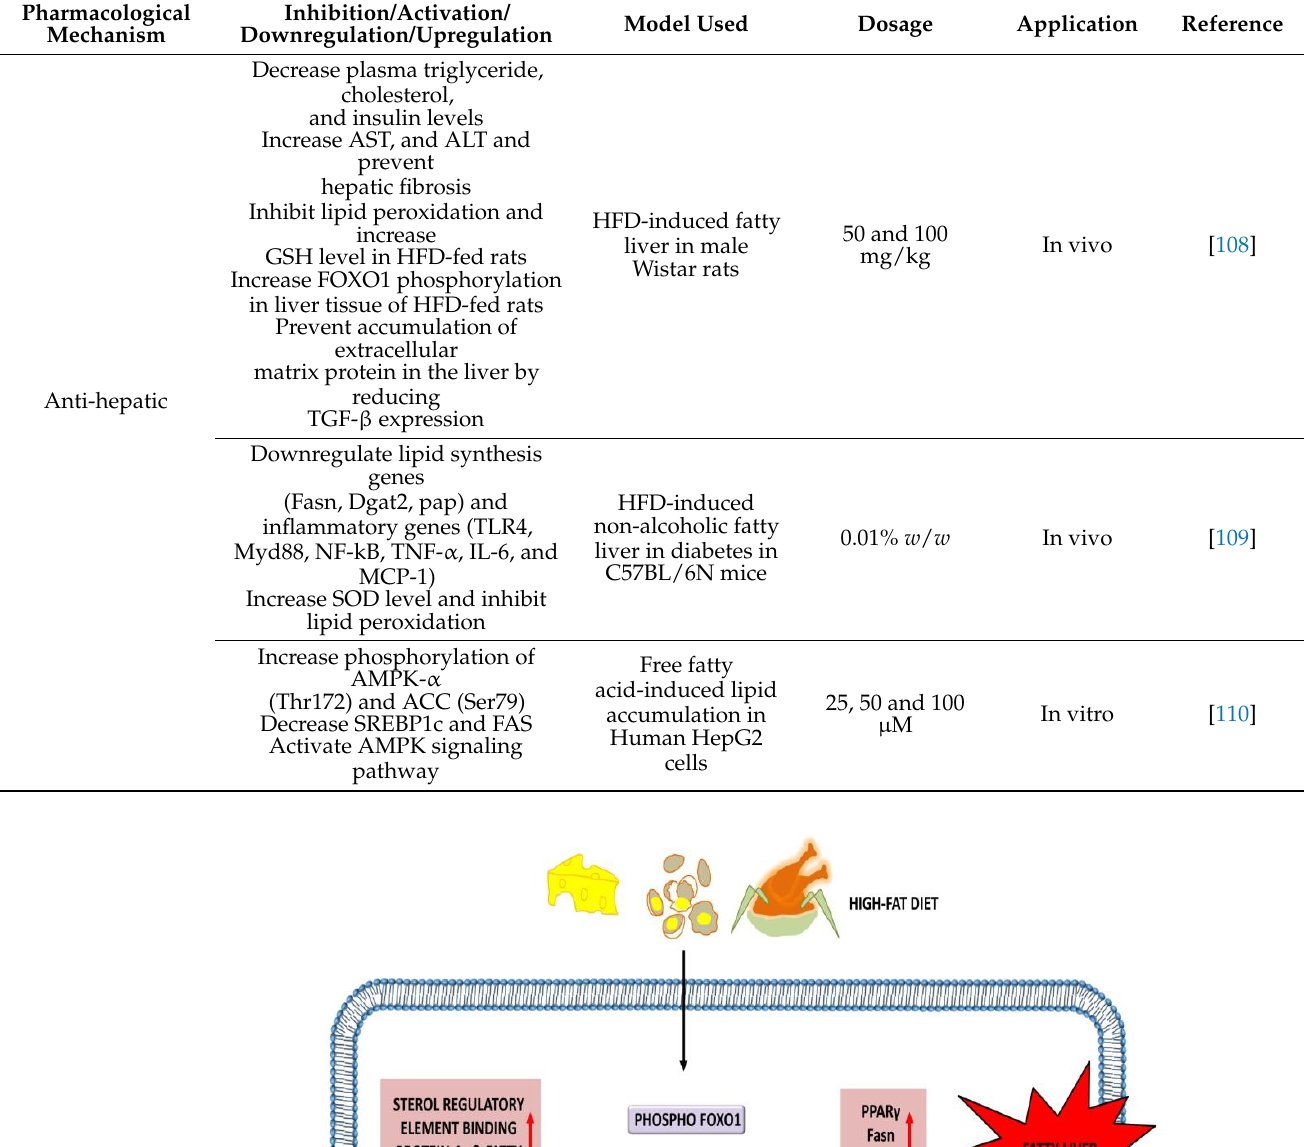
Table 6. Mechanism and function of esculetin in treatment of hepatic disease.